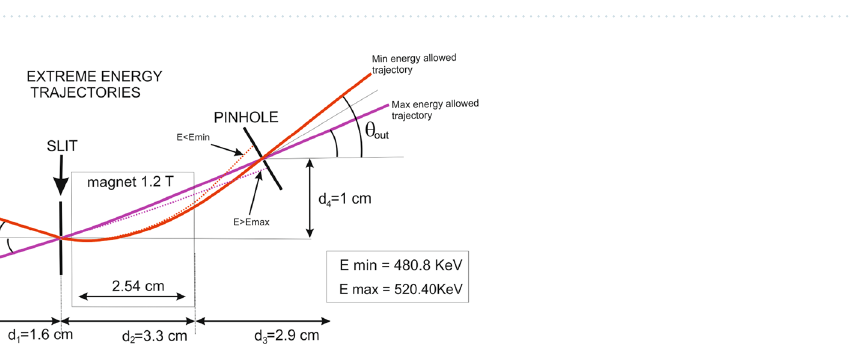
1 mm using initial source size of ∼